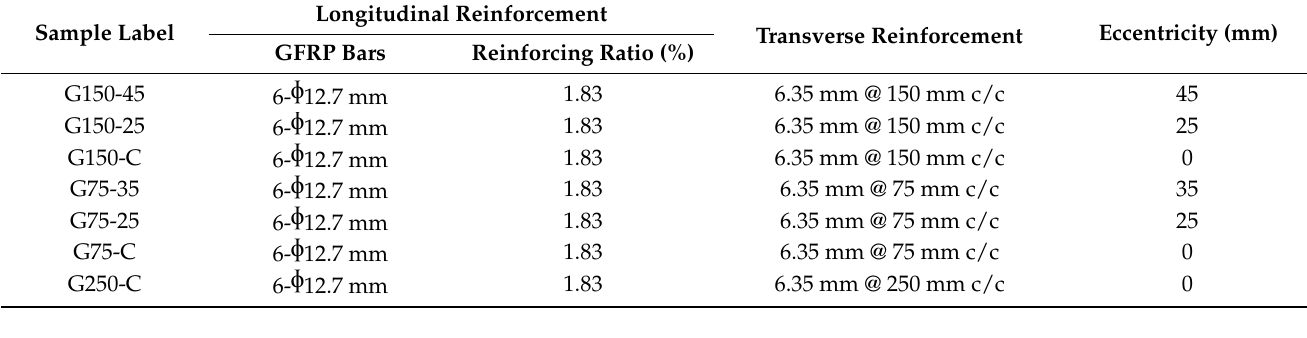
Table 3. Specimens for numerical simulations.